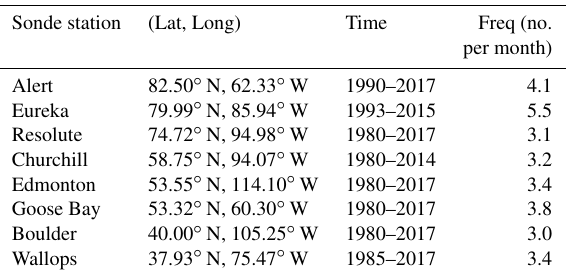
Table 1. The longitude, latitude, measurement time period and mean sampling frequency of the selected North American ozonesonde